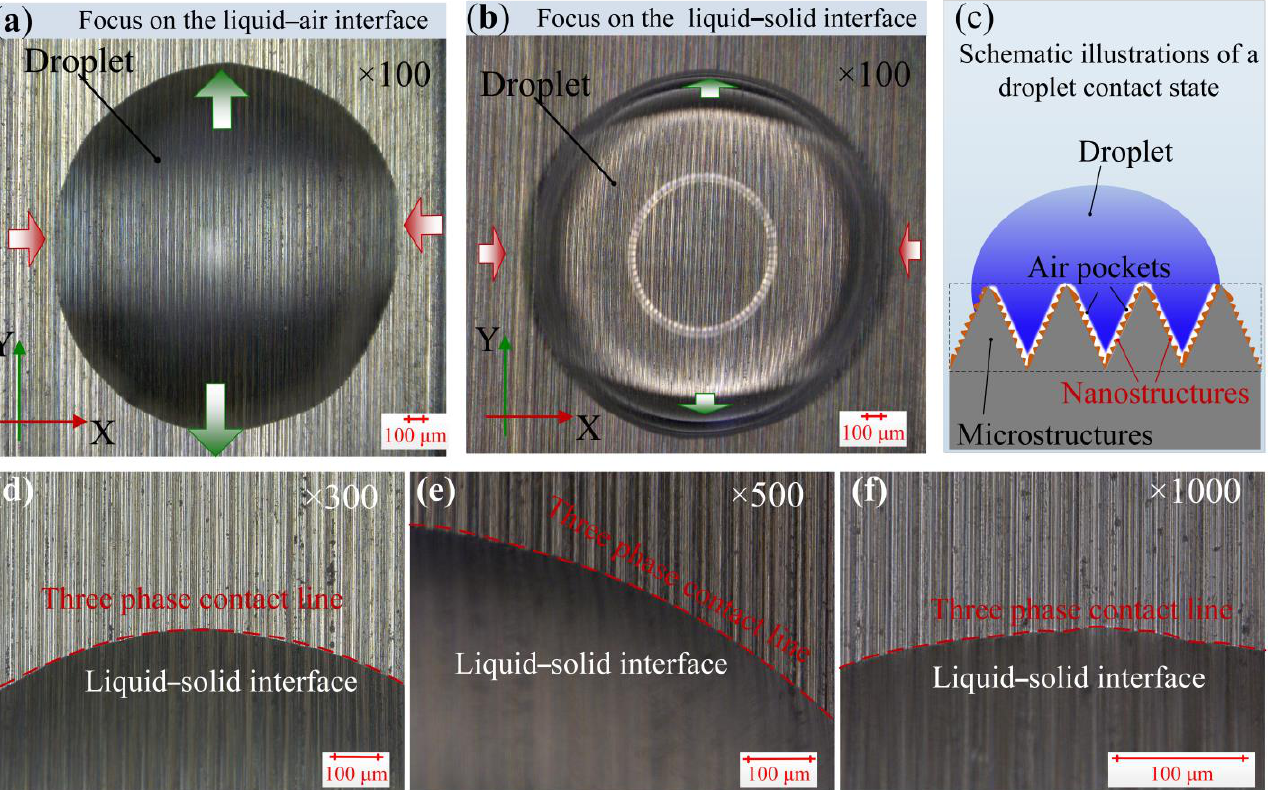
Figure 8. Digital microscopic images of droplet contact on the BLSH surfaces. ( a , b ) Contact mor- phologies of the droplet; ( c ) schematic illustration of the droplet contact mode; ( d – f ) enlarged partial views of contact at various magnifications.